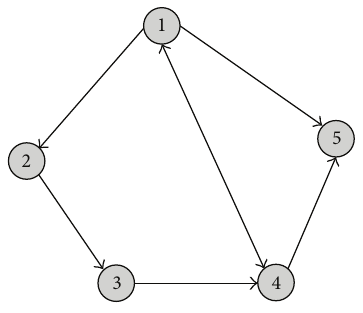
Figure 1: Interaction topology G 1